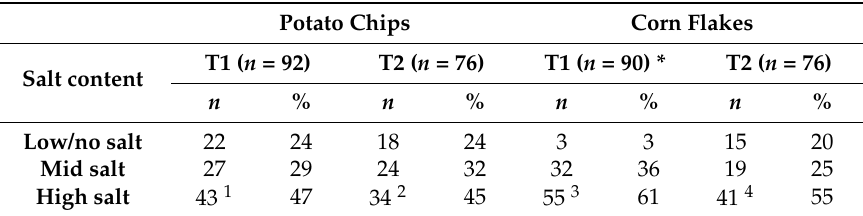
Table 3. Children’s most preferred samples.